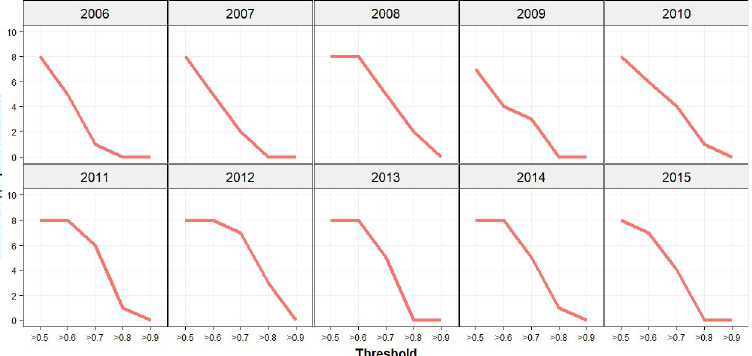
Fig 7. Appropriate antibiotics threshold analysis for single antibiotic choices. Incremental increases of 0.1 on the threshold from 0.5 onwards to determine appropriate antibiotics for single agent choices. On y-axis the number of appropriate antibiotics and on the x-axis the threshold value applied on the lower IQR is illustrated. Increase in threshold has gradually declined the number of appropriate